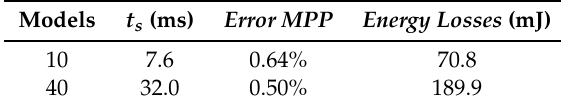
Table 4. Performance MPPT algorithm based in IPSM with 10 and 40 models.